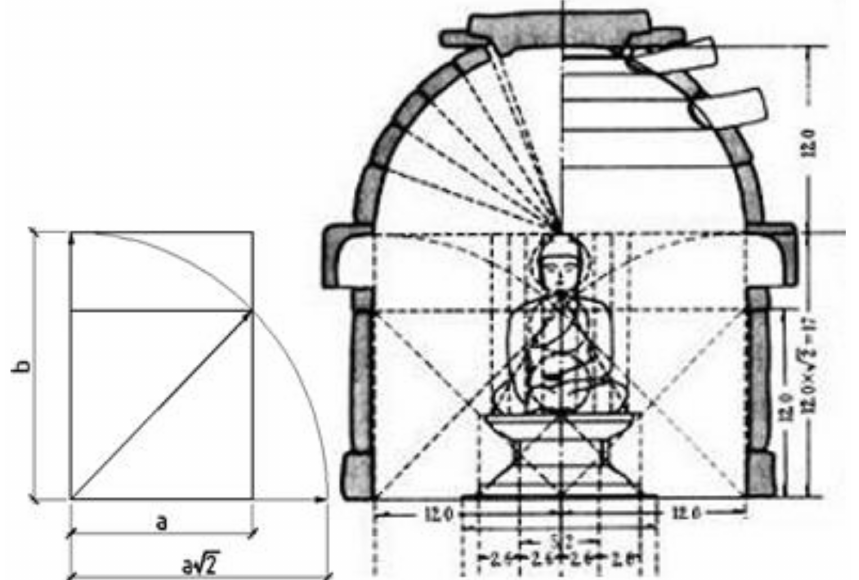
Figure 15. Use of proportions DIN 476 (1922 A.D.) before 751 A.D. by Korean architects and